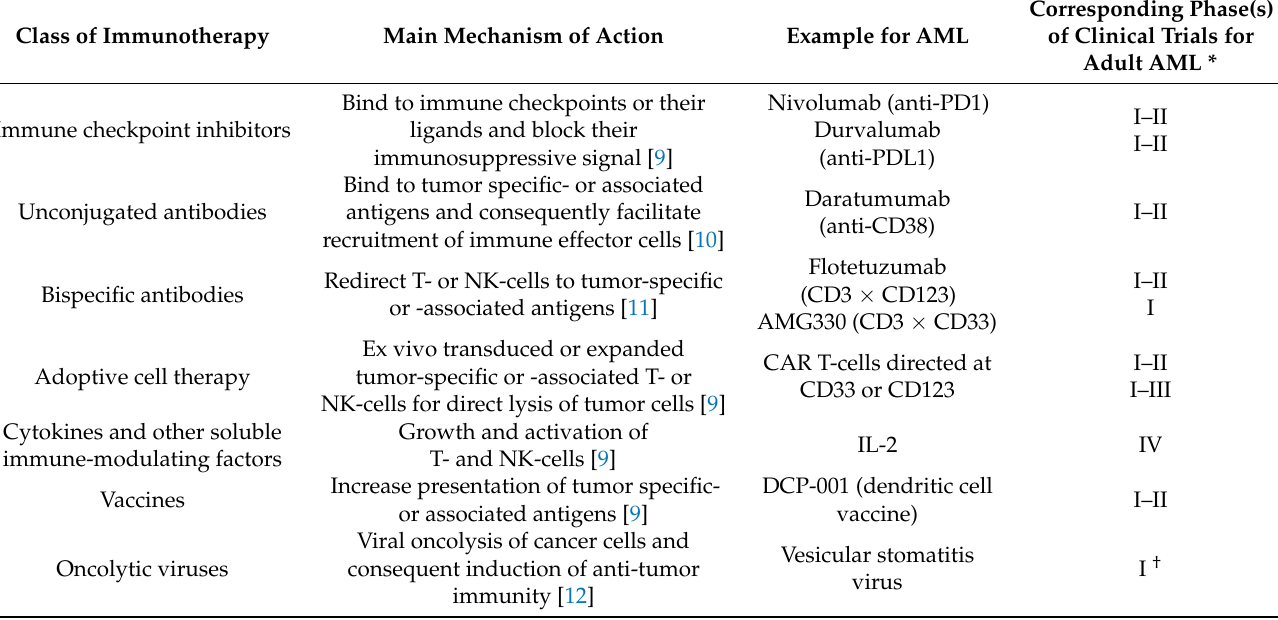
Table 1. Classes of immunotherapy drugs that are studied in AML, mechanisms of action and examples.